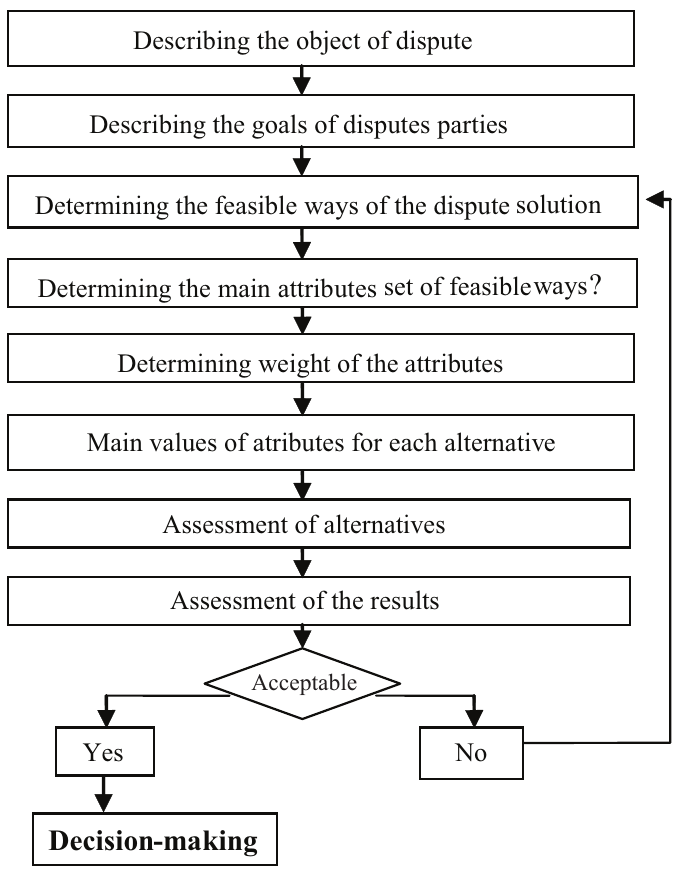
Fig. 1. The Multi-Attribute expert system for dispute